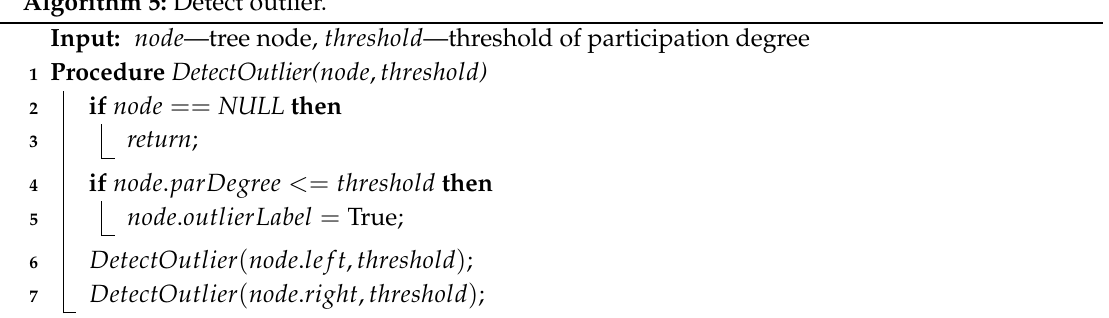
Algorithm 5: Detect